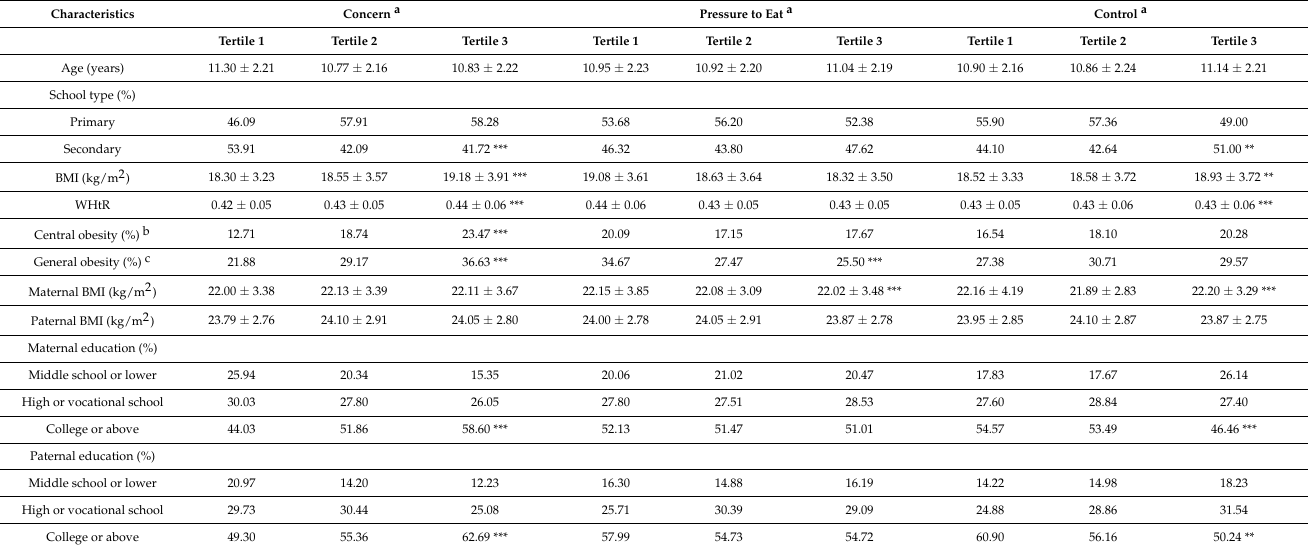
Table 2. Characteristics of children and their parents across parental feeding practices based on pooled baseline data during 2015 to 2017 from the Childhood Obesity Study in China Mega-Cities ( n =